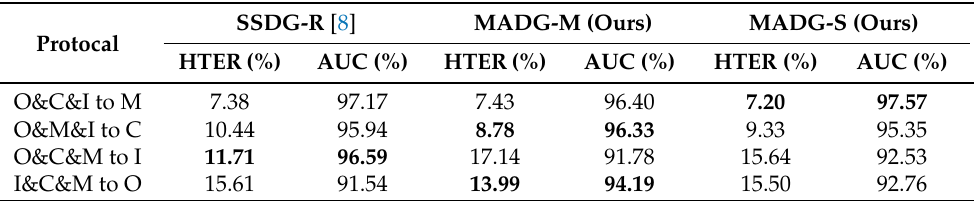
Table 6. Comparisons of different alignment strategies. The header is the baseline method and ours; the bold represents the optimal